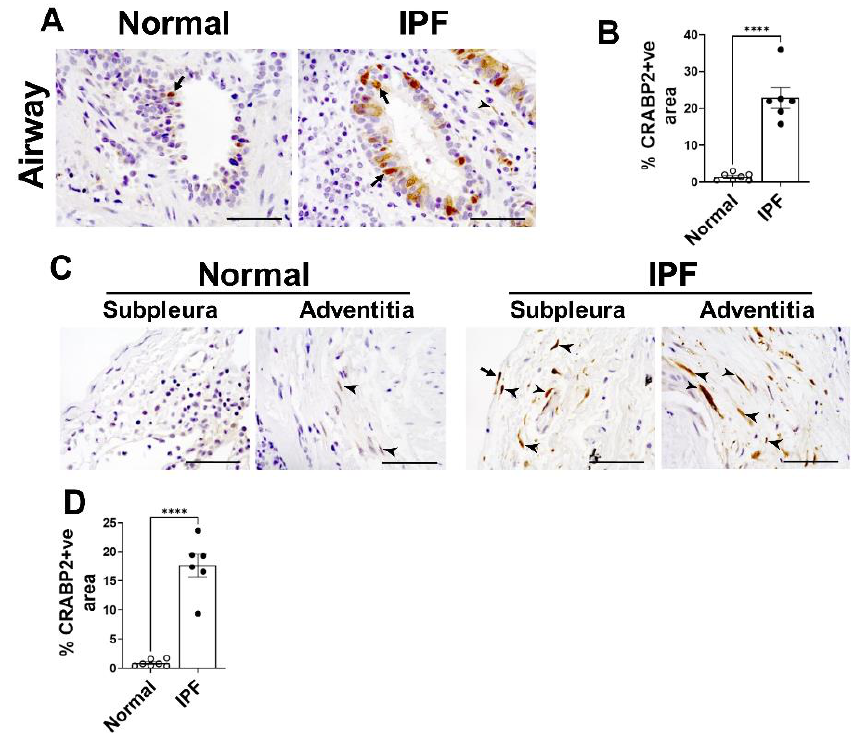
Figure 6. Upregulation of CRABP2 in the lungs of IPF. Immunostaining was performed using antibody against CRABP2 on the lung sections of normal and IPF. ( A ) Representative images of distal lung airway from normal and IPF lungs immunostained with anti-CRABP2 antibody and images were taken at 60× magnification. Scale bar: 50 µm. Arrows are used to highlight airway epithelial cells positive for CRABP2. ( B ) Quantification of the percent of CRABP2 staining in airways in the total lung area of images analyzed using BZ-X analyzer. ( C ) Representative images of subpleural and adventitia from normal and IPF lungs immunostained with anti-CRABP2 antibody and images were taken at 60× magnification. Scale bar: 50 µm. Arrows and arrow heads are used to highlight mesothelial cells lining the lung and spindle-shaped fibroblasts, respectively. ( D ) Quantification of the percent of CRABP2 staining in subpleural and adventitial area in the total lung area of images analyzed using BZ-X analyzer. ( **** p < 0.00005, n = 6 – 7/group; Student ’s t -test).